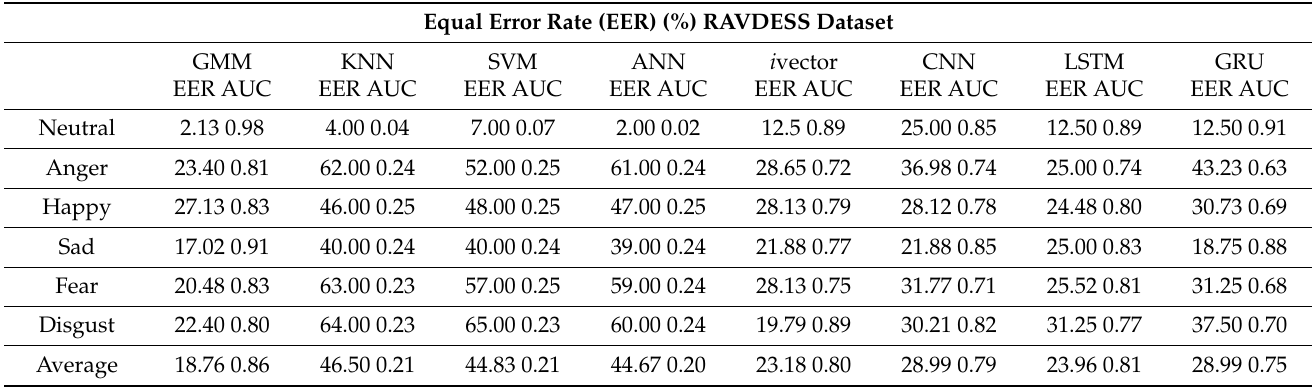
Table 6. Percentage EER values of classical and deep models for the RAVDESS